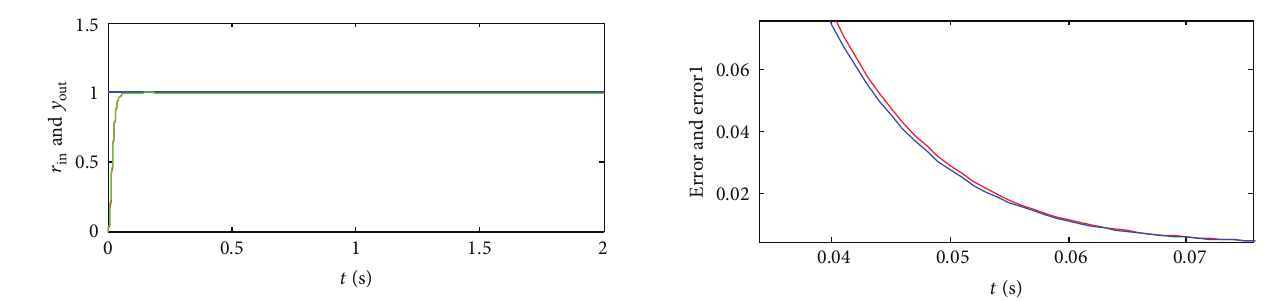
Figure 7: Amplified error